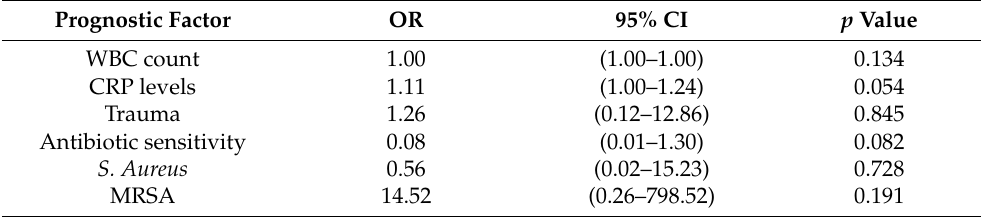
Table 3. Risk factor assessment for successful treatment of post-instrumentation SSI debridement, via multinomial logistic regression analysis, comparing the C-group to the reference S-group. Abbrevia- tions: OR, odds ratio; CI, confidence interval; CRP, C-reactive protein; MRSA, methicillin-resistant Staphylococcus aureus ; and WBC, white blood